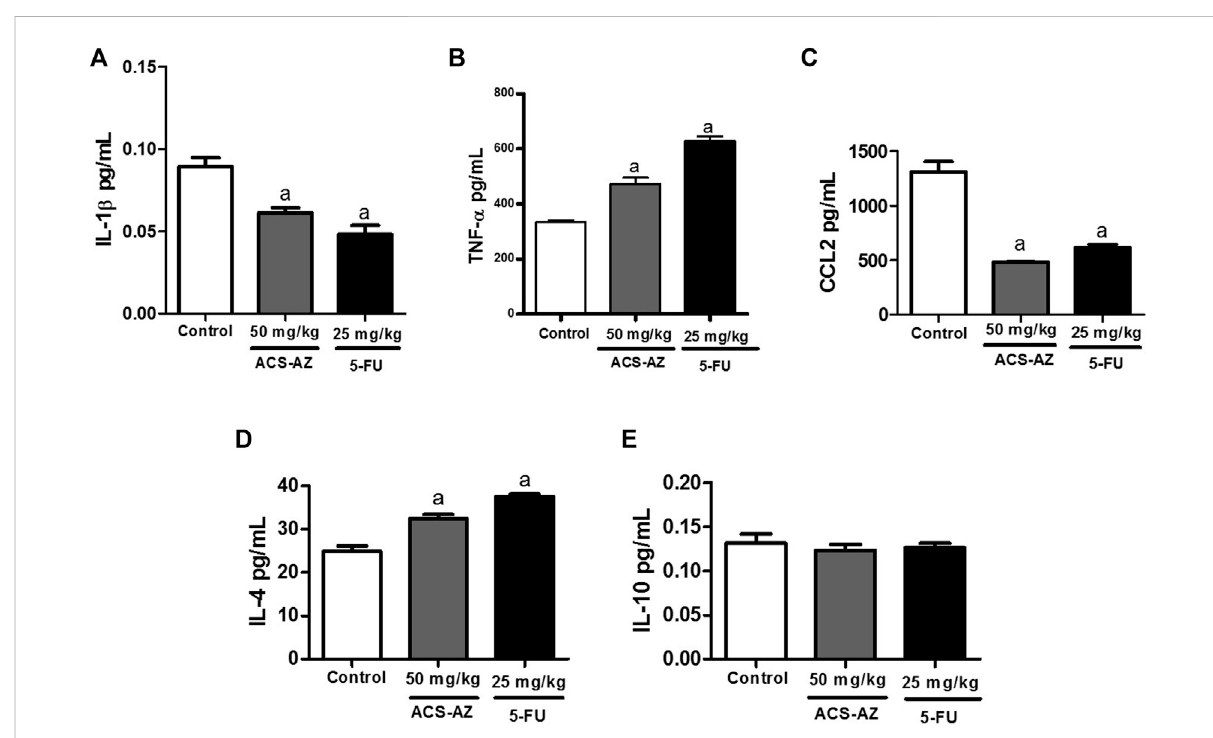
FIGURE 4 Effect of a 7-day treatment with ACS-AZ (50 mg/kg) or 5-FU (25 mg/kg) by intraperitoneal route on cytokine levels from the ascitic fl uid of Ehrlich ascites carcinoma-bearingmice. Levels (pg/ml) of IL-1 β (A) , TNF- α (B) , CCL2 (C) , IL-4 (D) , and IL-10 (E) weredetermined by mouse sandwich ELISAkitsforeachcytokine containingELISAplatespre-coatedwiththemonoclonalcaptureantibody.Theresults representthemean±SEM( n =8) analyzed by one-way ANOVA followed by Tukey test: a p < 0.05 vs. control. ACS-AZ: N ’ -(6-chloro-2-methoxyacridin-9-yl)-2- cyanoacetohydrazide; 5-FU: 5- fl uorouracil; IL: interleukin; TNF- α : tumor necrosis factor- α ; CCL-2: CC motif chemokine ligand 2.